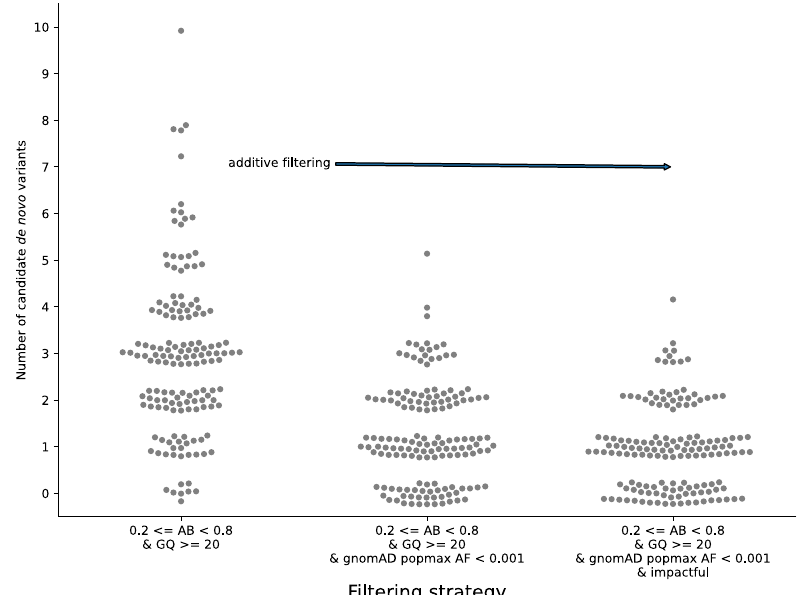
Fig. 2 The effect of combined fi lters on the number of predicted de novo mutations in exome studies. The number of candidate de novo variants for each of 149 exome trios. In each column, a point represents the number of de novo mutations per trio. Moving right along the plot, each column adds fi lters to the column that precedes it. The fi rst column uses only the sample information derived above, where AB is allele balance (alternate reads/(alternate reads + reference reads) and GQ is genotype quality. The second column adds fi lters on gnomAD allele frequency (AF); this reduces the average number of candidates. The third column further requires that the variant is “ impactful, ” according to